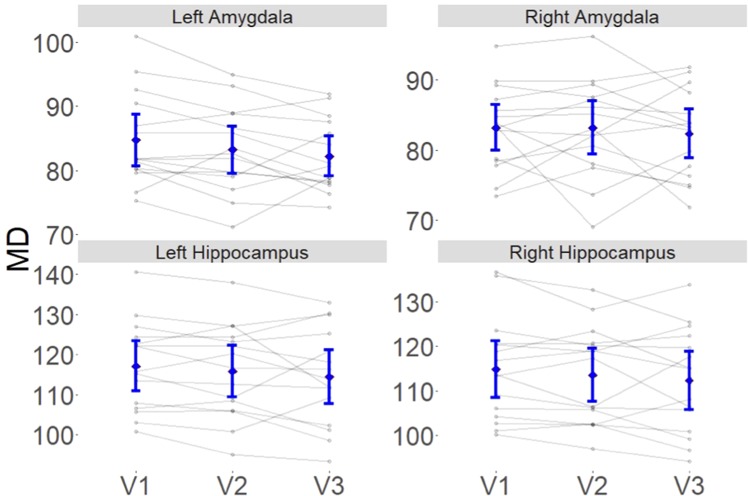
Single subjects measures and trajectories (in black) and group average and 95% CI (in blue) for V1, V2 and V3. In the left and right hippocampus, and the left amydala, the average MD was significantly lower at V3 than V1 (p = 0.4). Note that MD has been scaled by multiplying its original value by 1000.